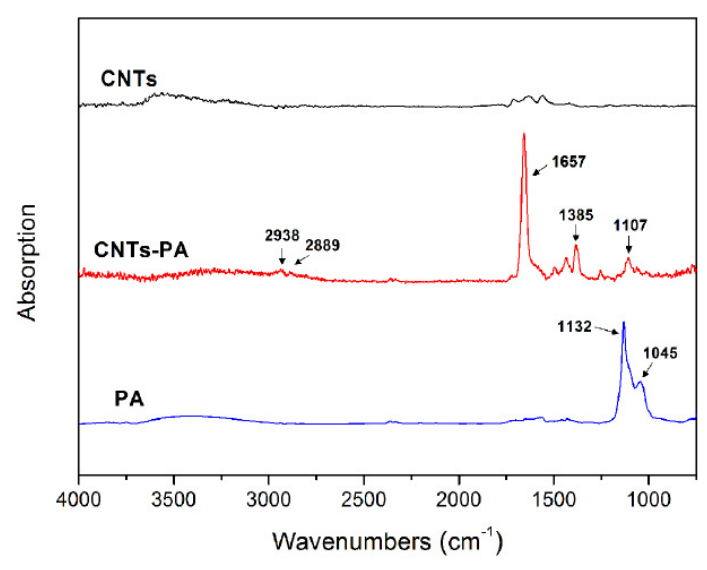
Figure 2. FTIR spectra of CNTs, PA and CNTs-PA.